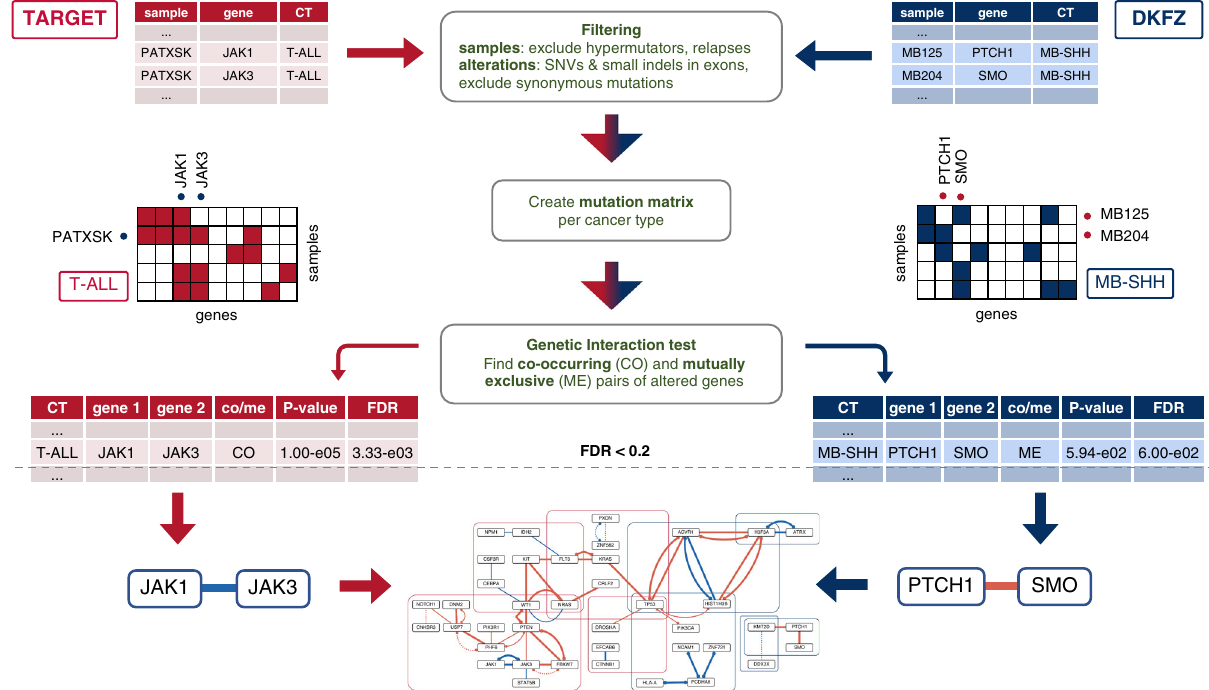
Fig. 2 Work fl ow depicting the statistical pipeline to detect genetic interactions. Starting with the original mutation fi les from the TARGET and DKFZ data set, samples and alterations are fi rst fi ltered after which a mutation matrix is created to record which samples contain mutations in a certain gene. Here, the candidate gene pairs JAK1 – JAK3 and PTCH1 – SMO are shown as examples. The matrix serves as input for the Permutation and WeSME test to detect signi fi cantly co-occurring or mutually exclusive pairs of altered genes. The resulting candidates from both data sets are merged into a genetic interaction map of childhood